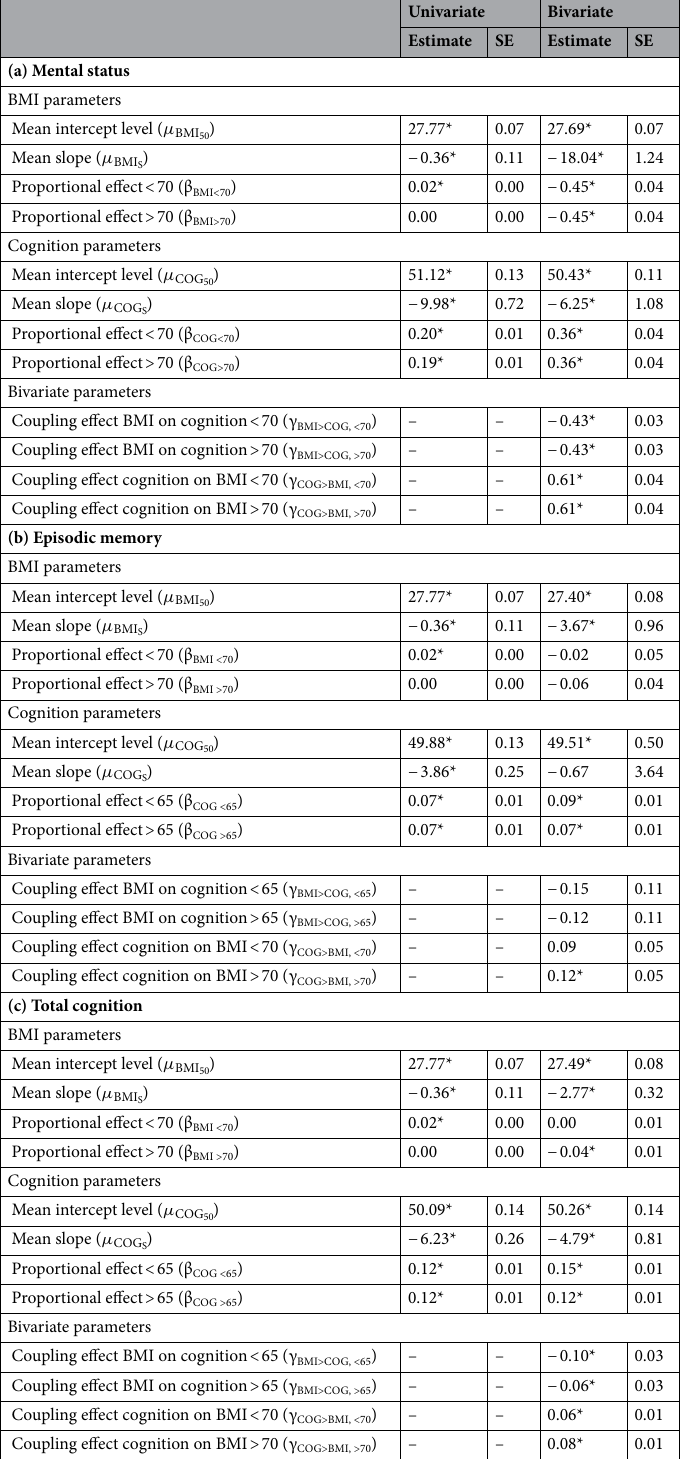
Table 1. Univariate and bivariate change in body mass index and cognitive abilities from age 50–89 in the Health and Retirement Study. SE standard deviation, BMI body mass index, COG cognition. Parameter estimates and standard deviations from the univariate and bivariate dual change score models of BMI and cognitive abilities in 23,892 individuals of European ancestry from the Health and Retirement Study. The slope parameters represent the mean linear change over 2 years. Proportional and coupling effects represent additional change over 2 years in relation to within and across-trait levels, respectively, at the preceding time point. BMI parameters are in BMI units and cognition parameters in T-score units. Models are adjusted for sex and education. A breakpoint was included to allow for differences in the proportional change and coupling parameters (mean slope is constant across age) before and after age 70 for BMI and mental status, and at 65 for episodic memory and total cognition. *p <